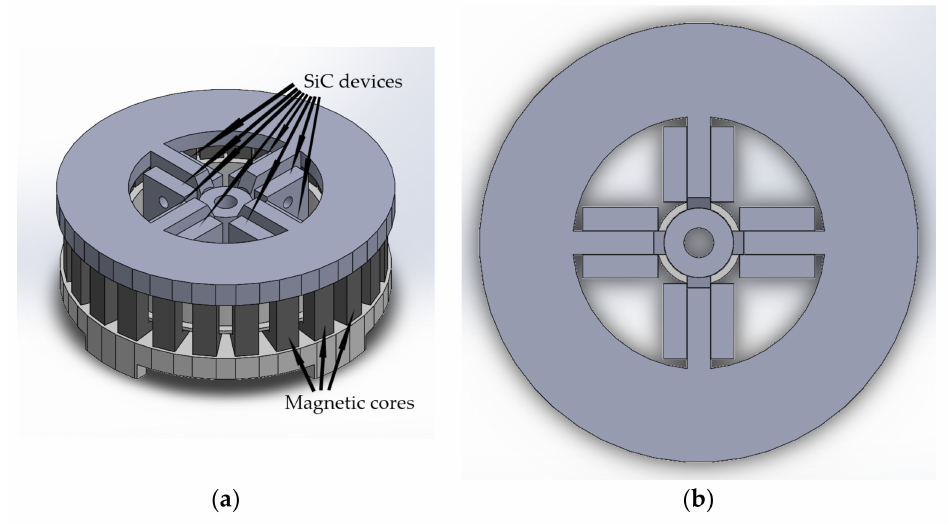
Figure 9. Schematic of integrated SiC-device and HF transformer. ( a ) Isometric view ( b ) Top